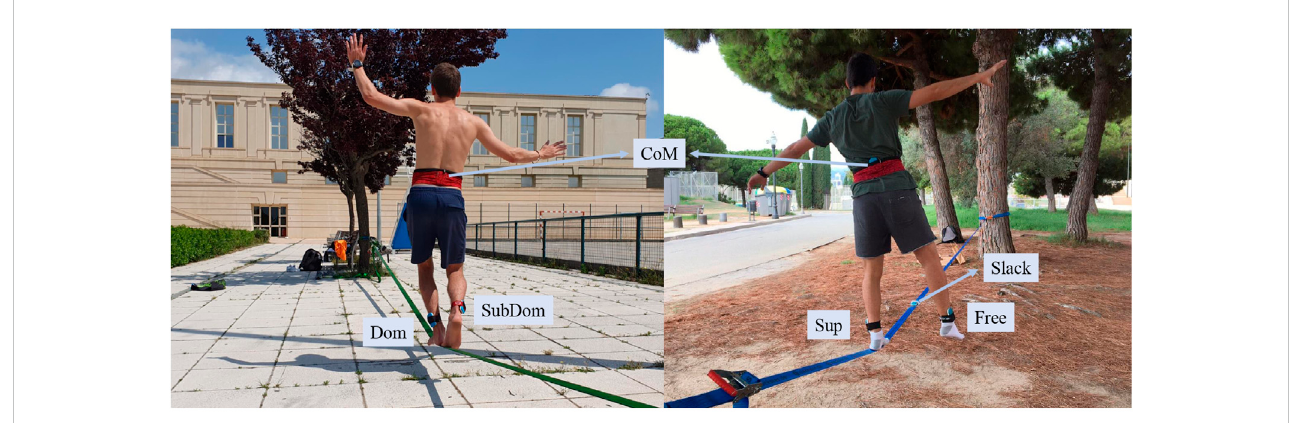
FIGURE 1 Representation of the task performed in each experiment: walking (left) and standing up balancing (right). Abbreviations of the monitored acceleration points: Dom = dominant leg; SubDom = subdominant leg; CoM = centre of mass; Sup = support leg; Free = free leg; Slack =